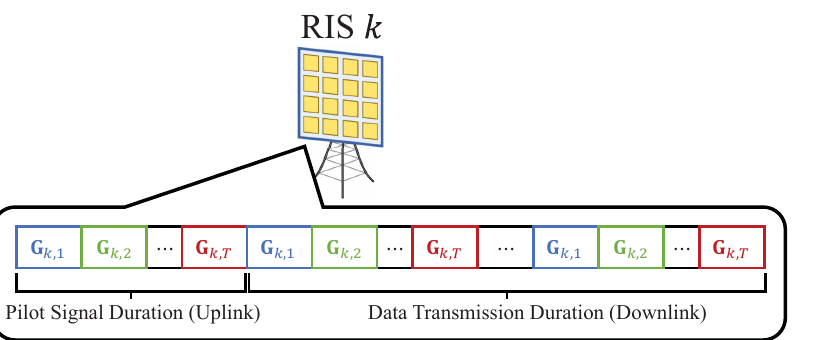
Figure 2. RIS reflection matrix shifting in pilot signal duration and data signal